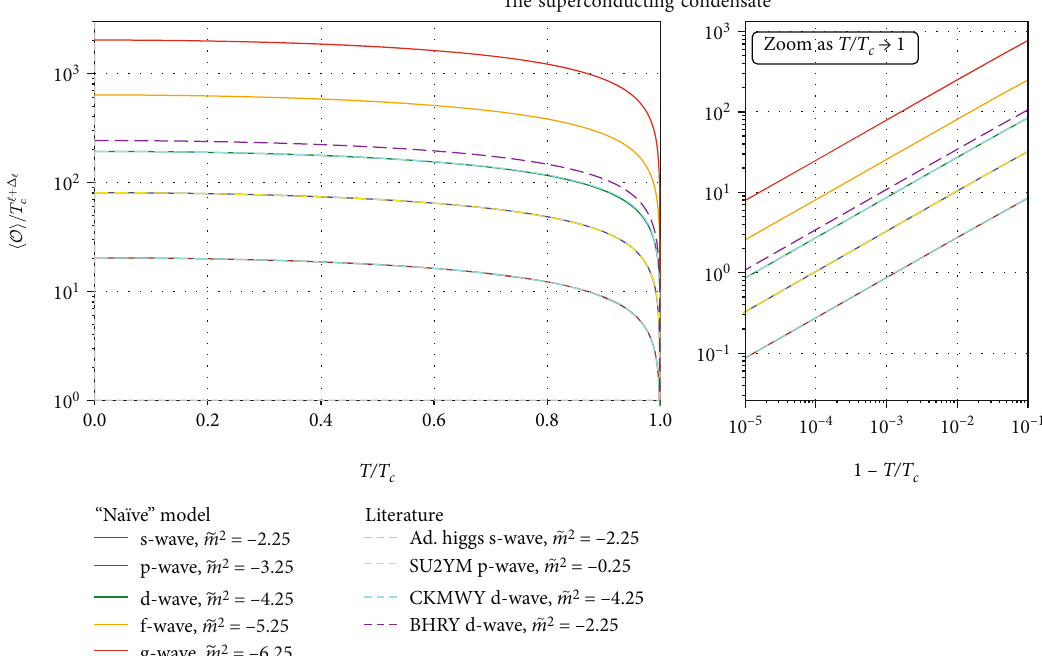
Fi g ure 2: Naïve models for s-, p-, d-, f-, and g-wave superconductors and comparison with the Abelian Higgs s-wave, SU(2) Yang-Mills p- wave, and CKMWY as well as BHRY d-wave superconductor. All masses are chosen at the respective Breitenlohner-Freedman bound such that the anomalous dimension Δ ℓ agrees in all cases.